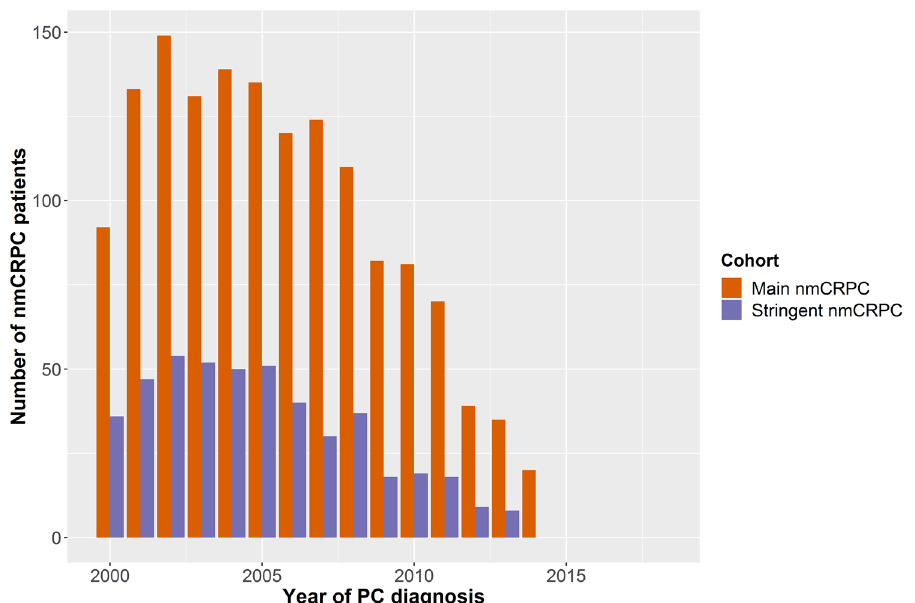
Figure 2. Number of patients diagnosed with PC each year who later progressed to meet inclusion criteria for the main and stringent nmCRPC cohorts. The patients in each column of this graph had a PC diagnosis in the year specified on the x-axis. nmCRPC: non-metastatic castration-resistant prostate cancer; PC: prostate